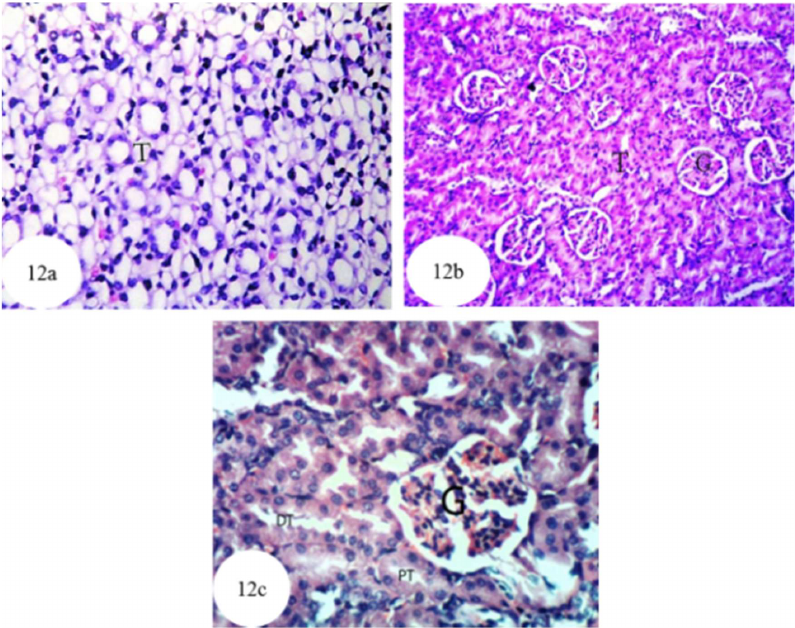
Figure 12. Photomicrographs of haematoxylin and eosin stained sections of kidney of a normal control rat showing normal histological structure of the medullary portion and the tubules (T) ( a ) (×256), normal histological structure of the cortex portion containing glomerulus (G) and tubule (T) ( b ) (×128) and normal histological structure of the renal parenchyma where glomerulus (G), proximal tubule (PT) and distal tubule (DT) were observed ( c ) (×400).